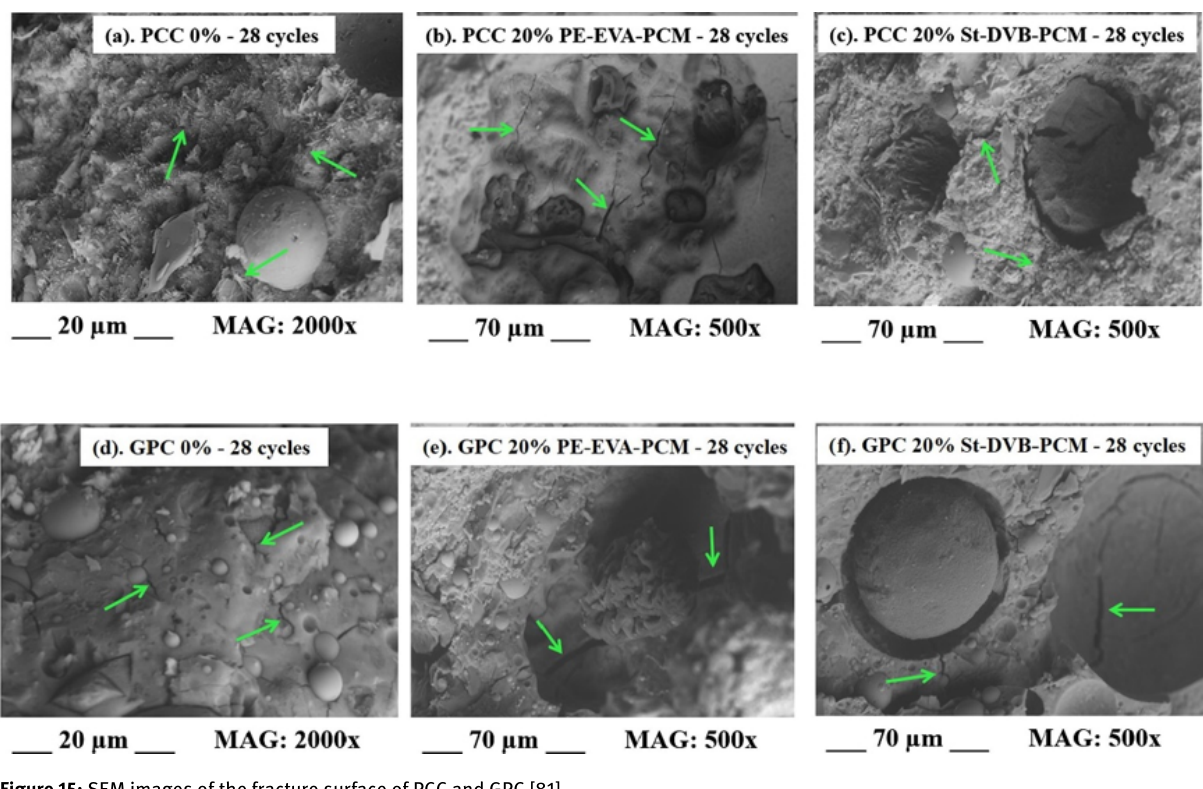
Figure 15: SEM images of the fracture surface of PCC and GPC [81]